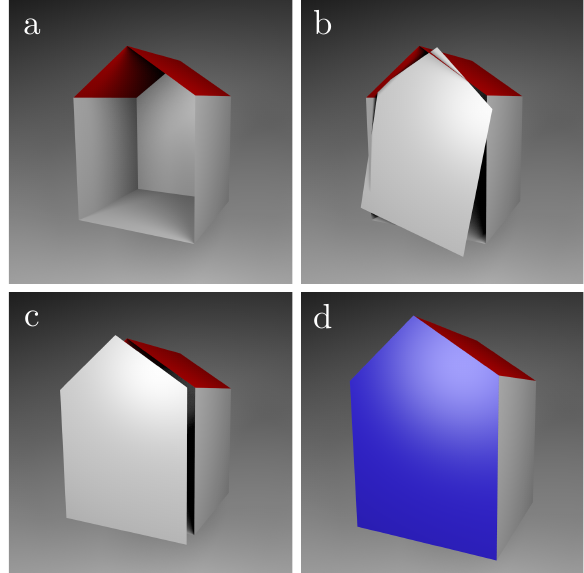
Figure 2: Geometrical and topological errors of volumetric ob- jects in semantic 3D City models: missing (a), tilted (b), trans- lated (c) or incorrectly oriented surfaces